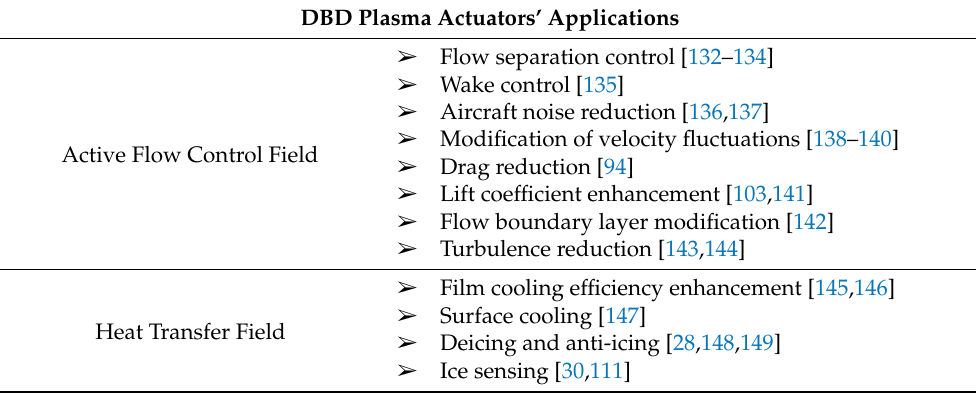
Table 3. Summary of the possible applications of DBD plasma actuators.